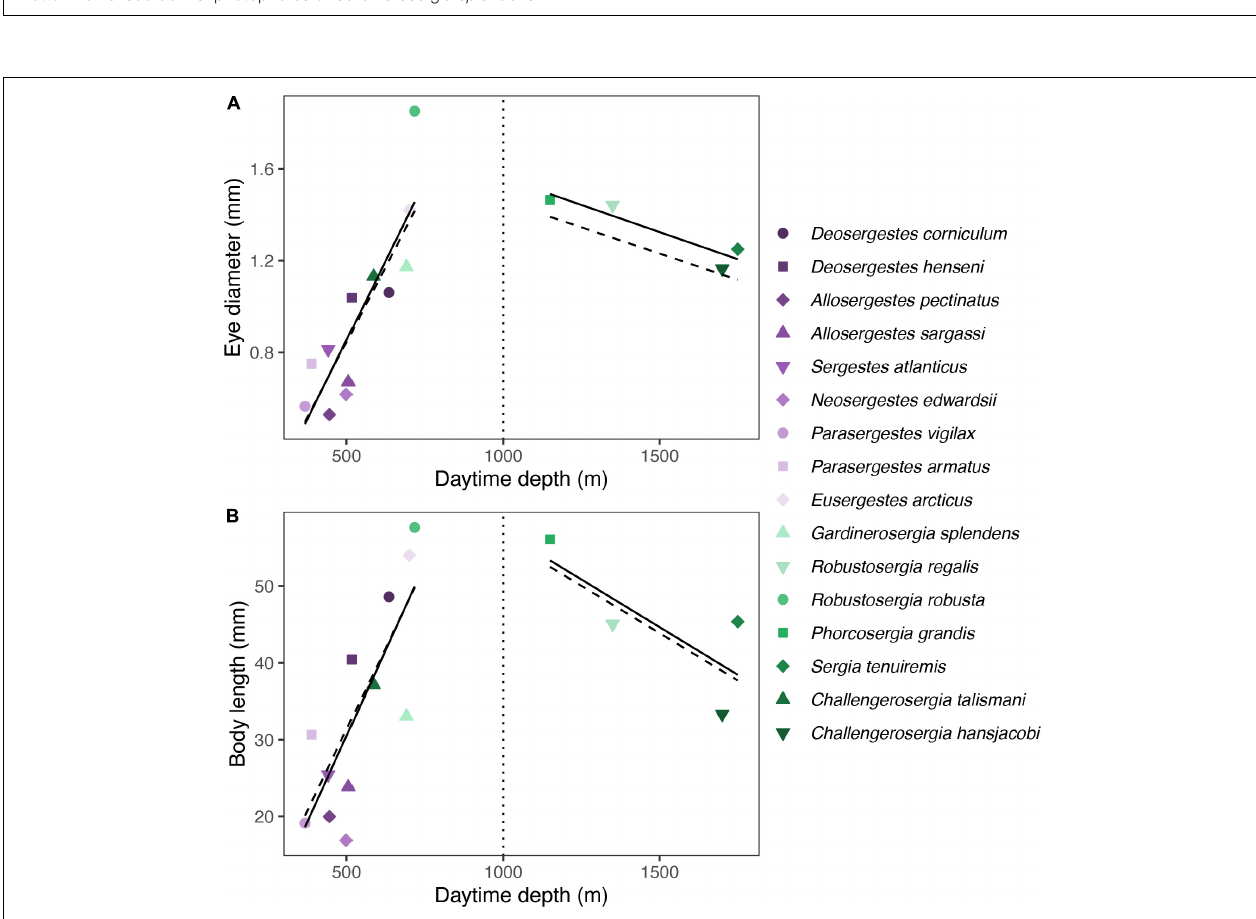
FIGURE 5 | Eye and body size variation with depth. Plots shows mean eye diameter (A) and mean body length (B) vs. daytime depth for -sergia (green) and -sergestes (purple) groups of sergestid shrimps. Regression lines indicate phylogenetic generalized least squares (PGLS) regressions. Models were run with λ set to either 0 (solid line) or 1 (dashed line), accounting for the lowest and highest bounds of phylogenetic signal in model residuals, respectively. The dotted vertical lines in plots indicate the transition from the mesopelagic to the bathypelagic zone.